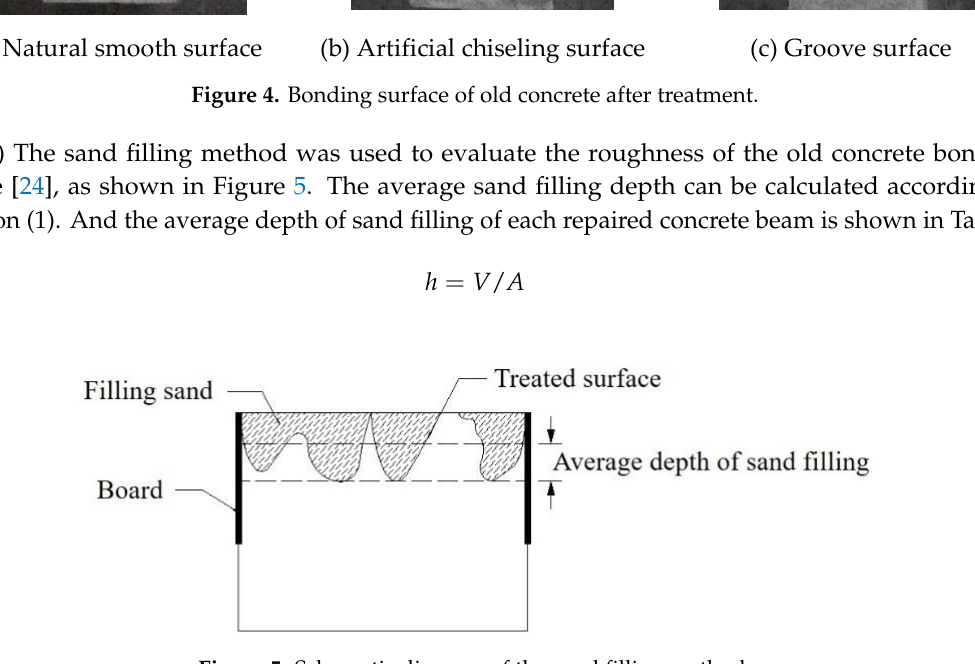
Figure 4. Bonding surface of old concrete after treatment.